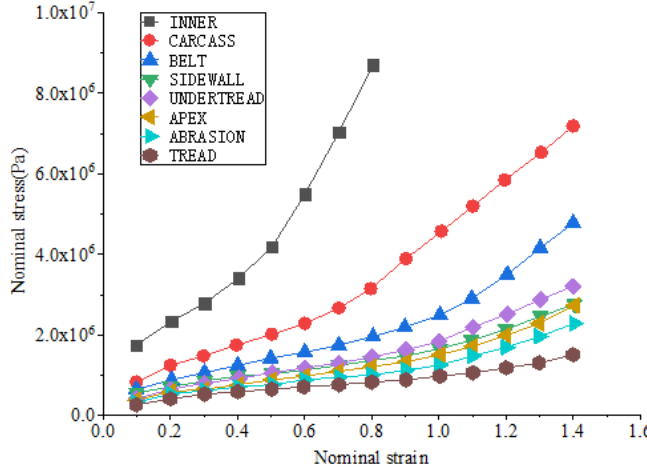
Figure 11. Stress–strain response curve of different rubber compounds.